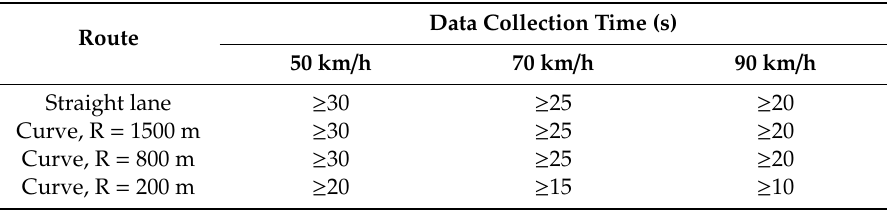
Table 1. Experimental